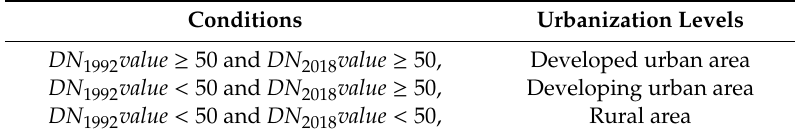
Table 1. Conditions for dividing di ff erent urbanization level zones by the ranges of DN